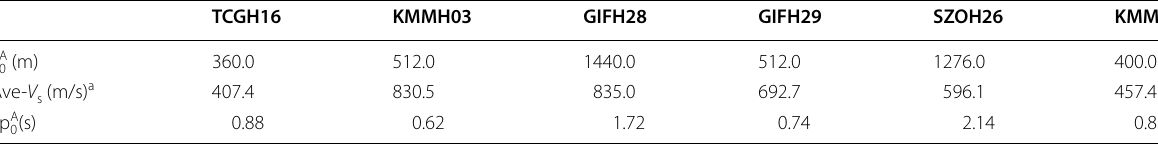
a Thickness-averaged S-wave velocity